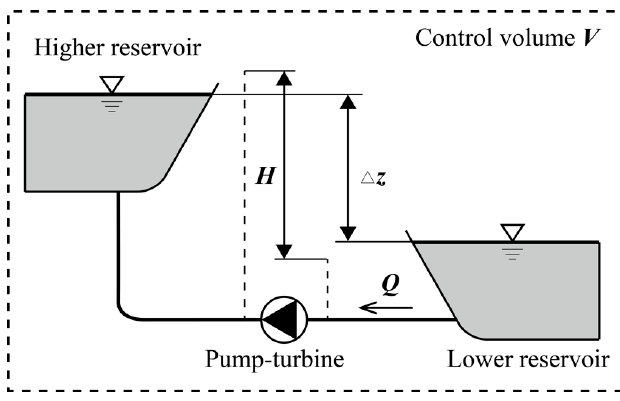
Figure 1. Pump-turbine system in pump mode.